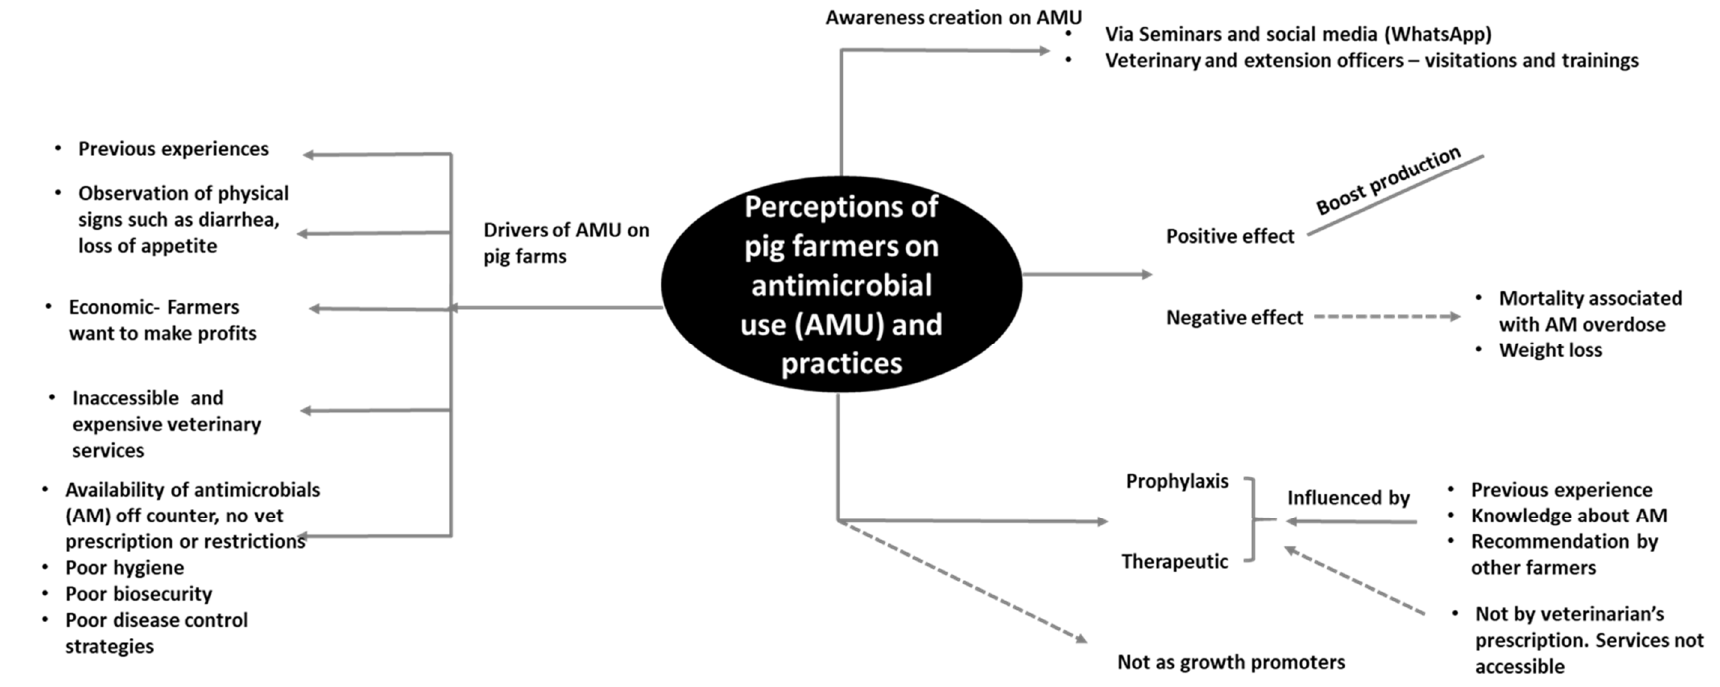
Figure 2. A thematic map showing perceptions of pig farmers that participated in the focus group discussions (FGDs) on antimicrobial use (AMU) and practices, drivers for overdependence on AMU, and challenges confronting pig production in Ogun State. AM: antimicrobial.